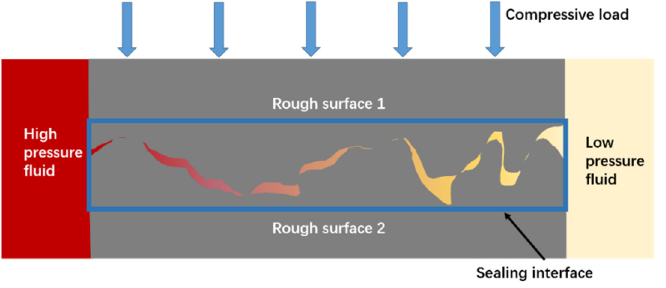
Figure 1. A schematic showing the sealing medium through the sealing interface of a metal-to-metal